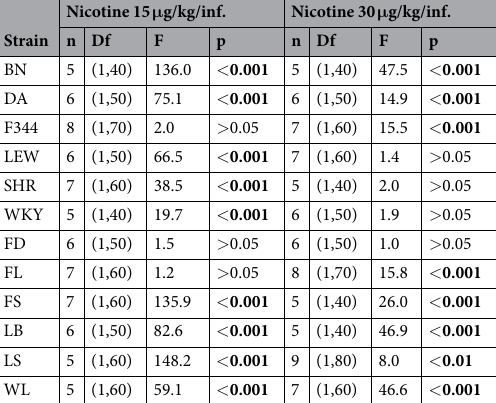
Table 1. Statistical analysis of self-administration data: I. Spout difference. Twelve isogenic strains of rats self-administered nicotine (15 or 30 μ g/kg/inf, i.v.) for 10 daily 3 h sessions with a flavored cue. A same-sex conspecific consuming the same cue served as a demonstrator to provide an environment for social learning. The number of active vs inactive licks were analyzed using two-way repeated measures ANOVA. The p values that achieved statistical significance (p < 0.05) are highlighted in